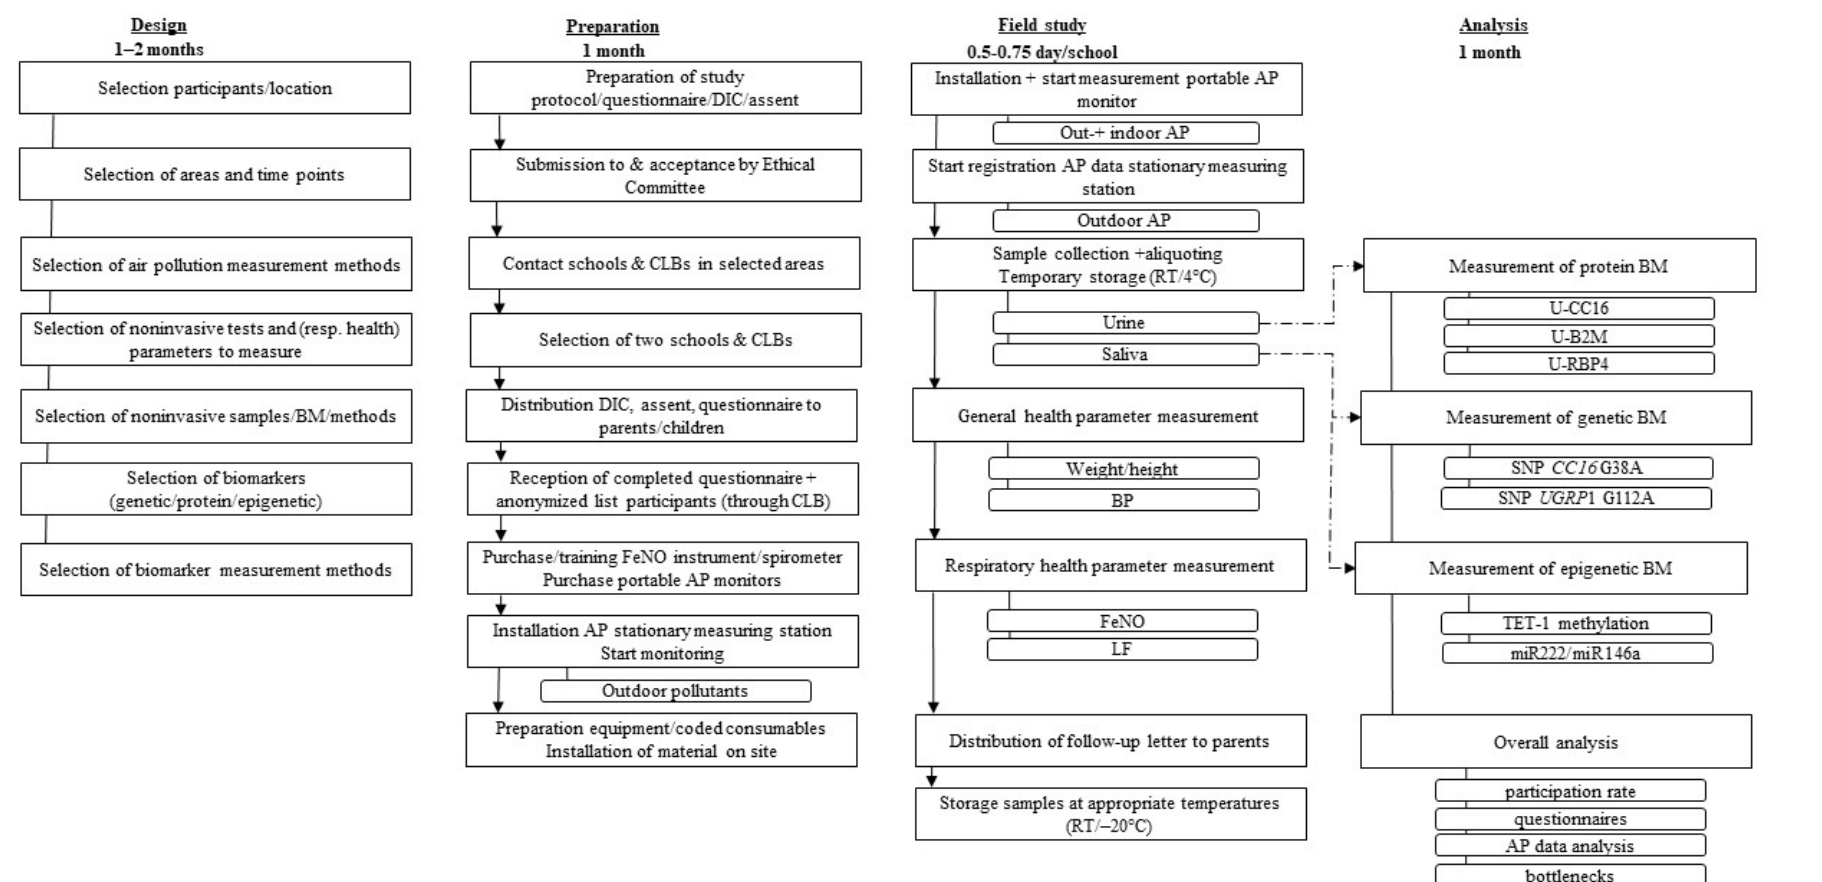
Figure 1. Flowchart of the feasibility study, comprising the several steps of design, preparation, the orchestration of the field study and the analysis of the measured parameters, including the time frame required for each of these steps. AP: air pollution; β 2M: beta-2-microglobulin; BM: biomarker; BP: blood pressure; CC16: club cell protein; CLB: pupil guidance center, DIC: document of informed consent; FeNO: fractional exhaled nitric oxide; LF: lung function; RT: room temperature; SNP: single nucleotide polymorphism; TET-1: ten-eleven translocation methylcytosine dioxygenase 1; UGRP1: uteroglobin-related protein.